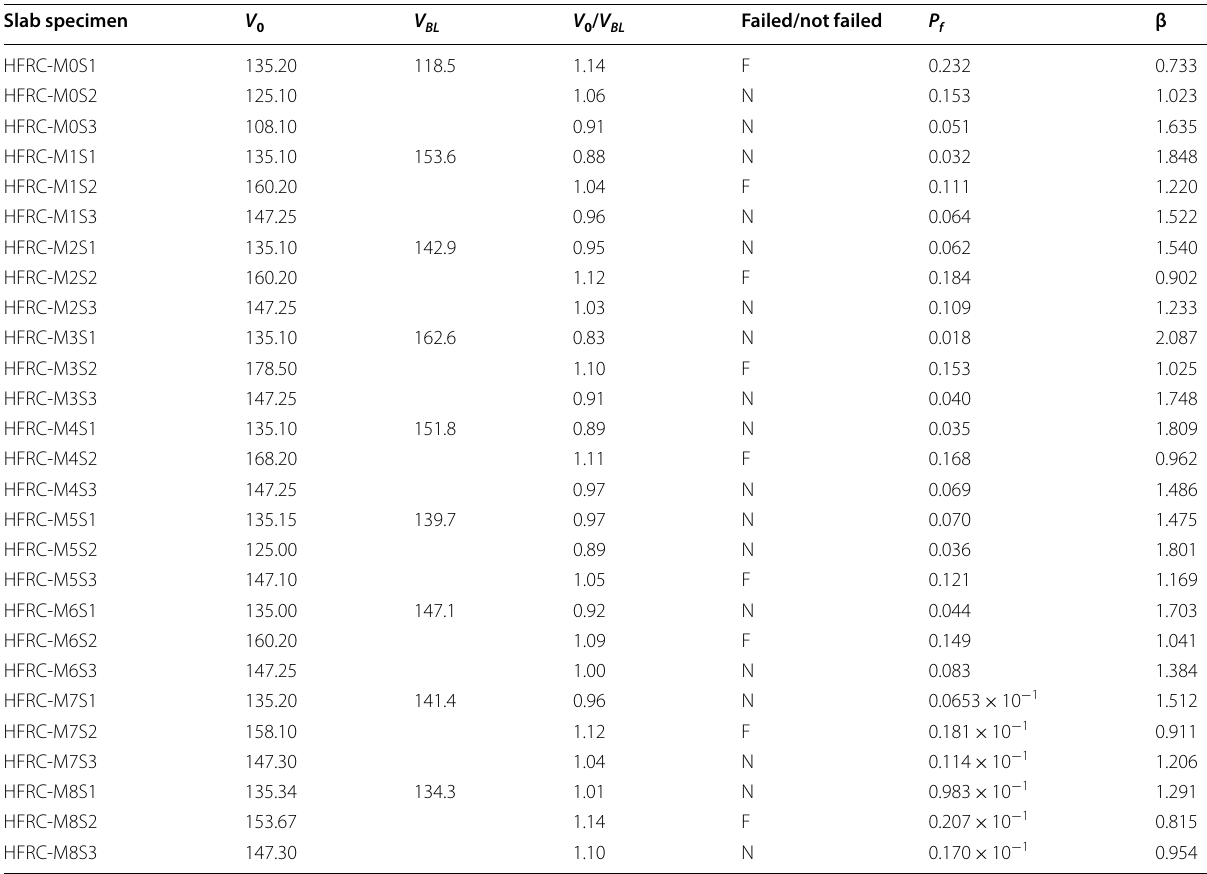
Table 5 Failure probability and reliability indices of each specimen.